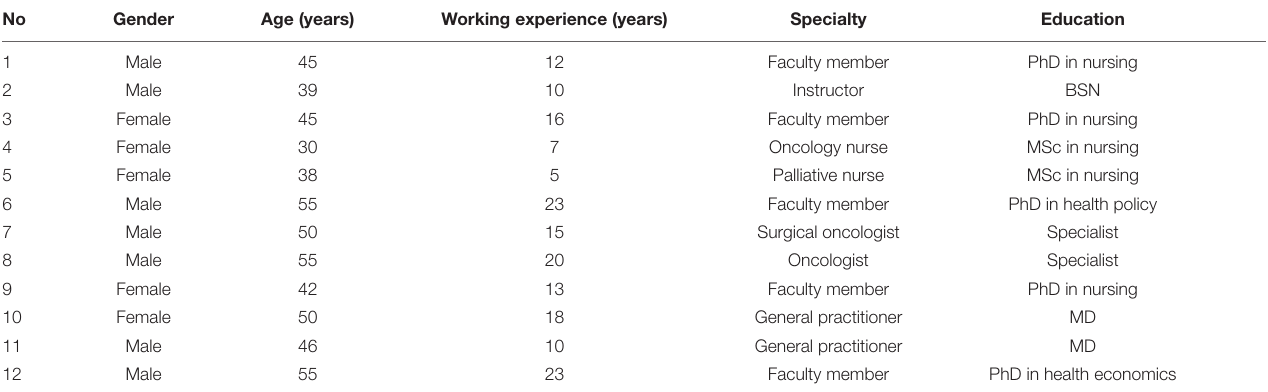
TABLE 3 | The demographic characteristics of participants in Phase